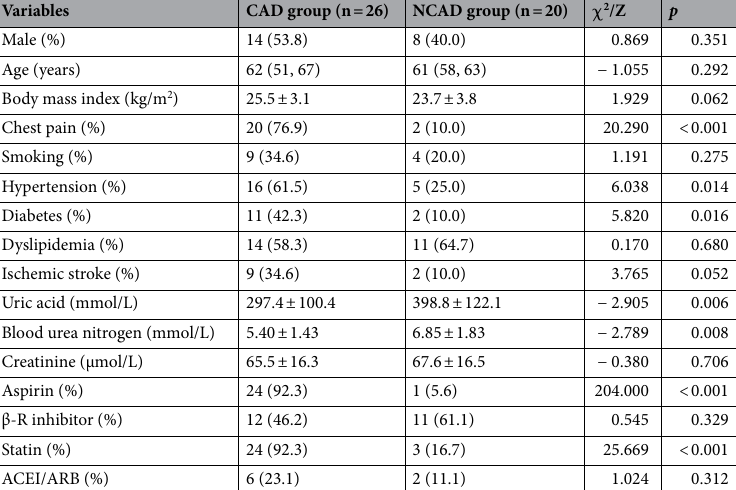
Table 2. Baseline characteristics of CAD and NCAD